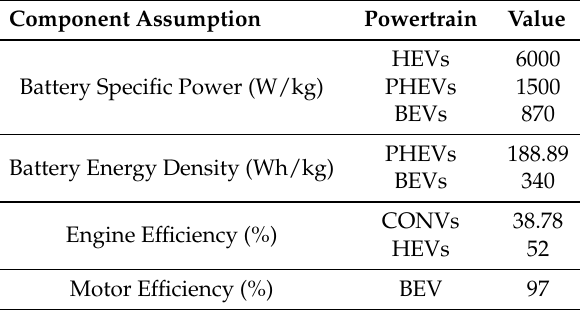
Table 3. Vehicle Component Assumptions.